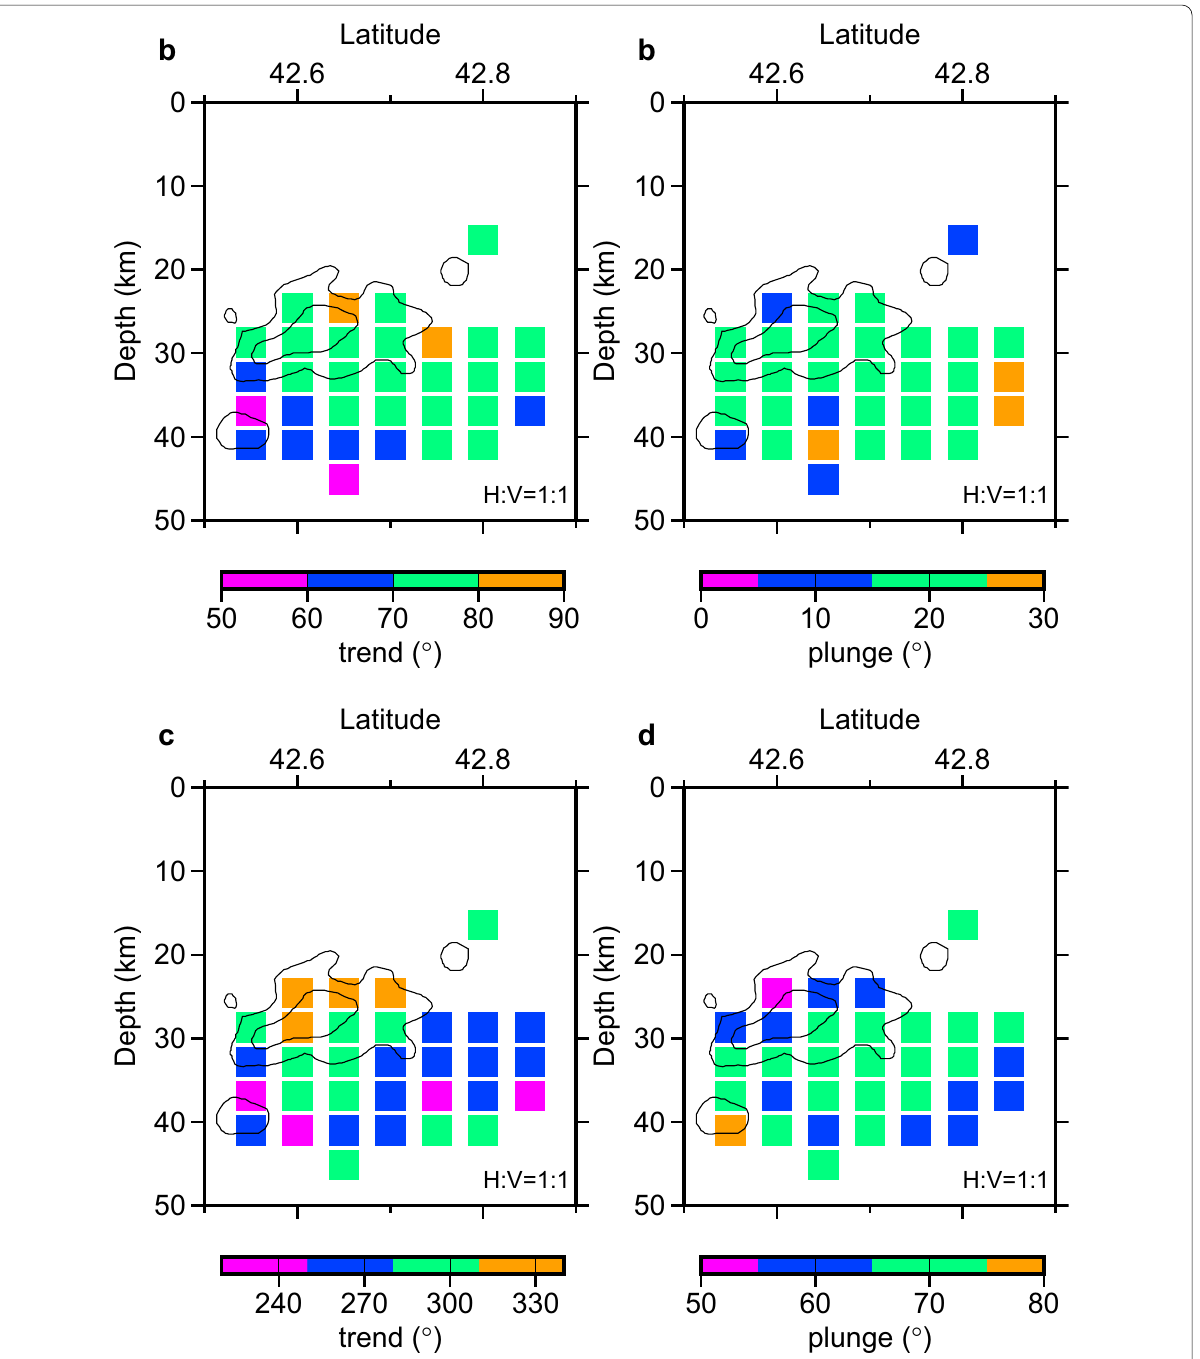
Fig. 8 Spatial pattern of the trend and the plunge. a The trend of σ 1 -axis, b the plunge of σ 1 -axis, c the trend of σ 3 -axis, and d the plunge of σ 3 -axis. The coseismic slip was indicated by contours with 0.6 and 1.2 m (Asano and Iwata